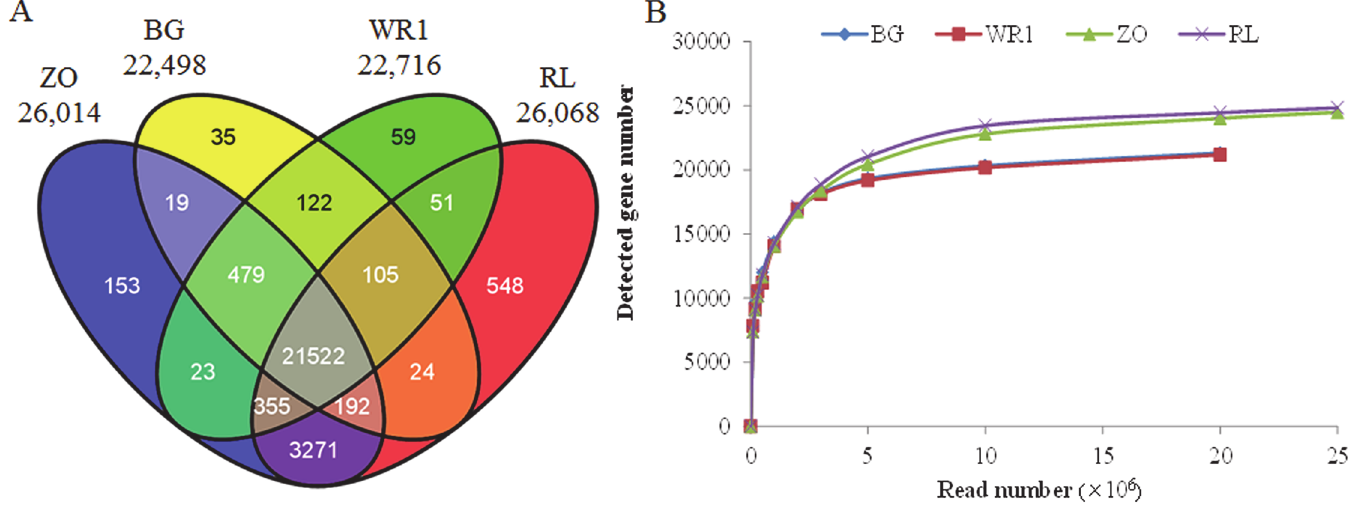
Fig 1. Summary of gene number identified from the Asian lotus transcriptome. (A) Venn diagram of genes expressed in the four cultivars. (B) Correlations between detected genes number and reads number in the four cultivars.